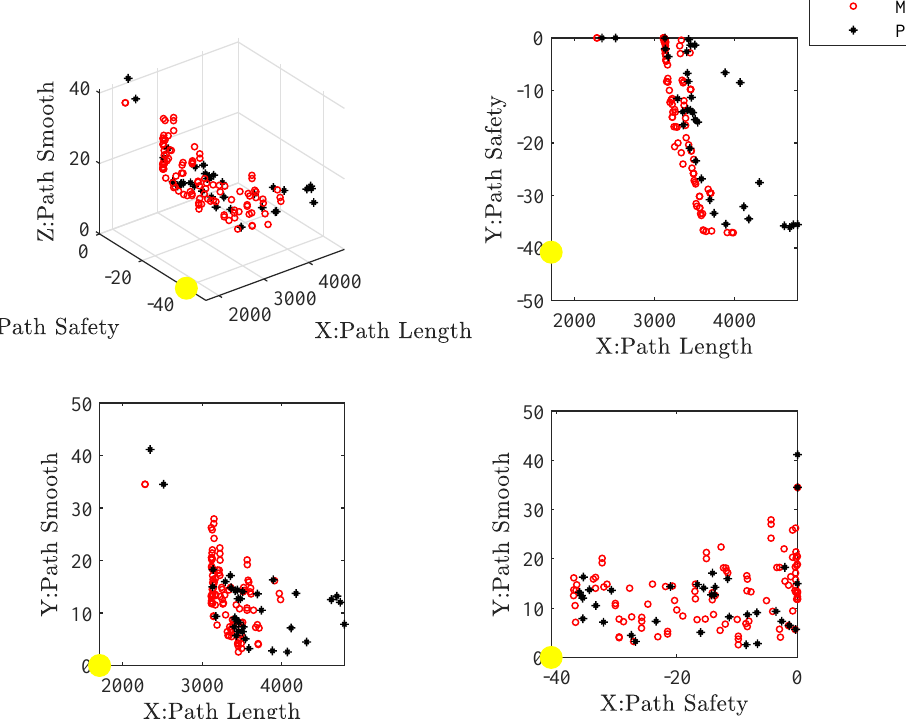
Figure 10. Approximate Pareto fronts for Figure 8B: MOEA vs.